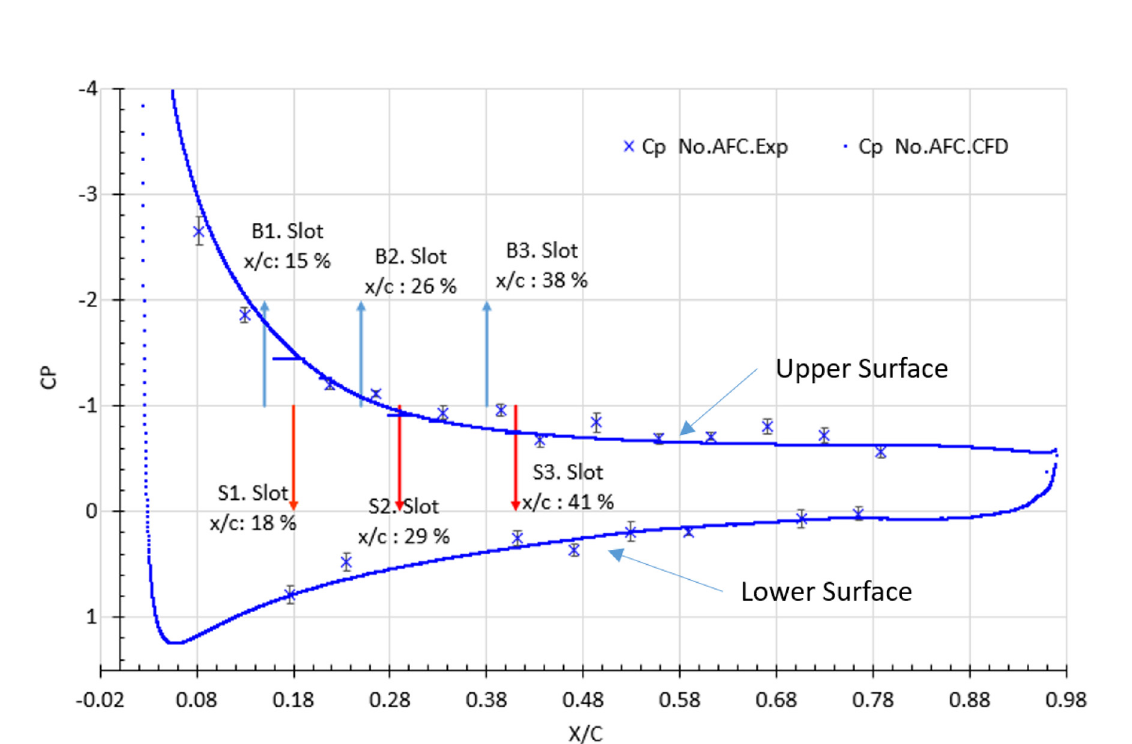
Fig. 5. Pressure coef fi cients around the aerofoil pro fi le of the baseline case (without